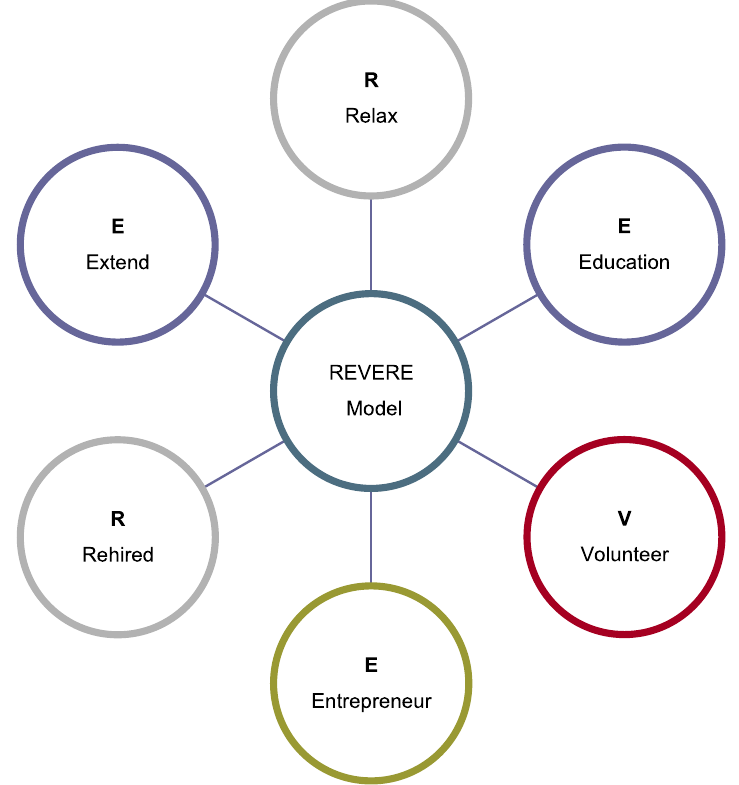
Figure 1. The REVERE